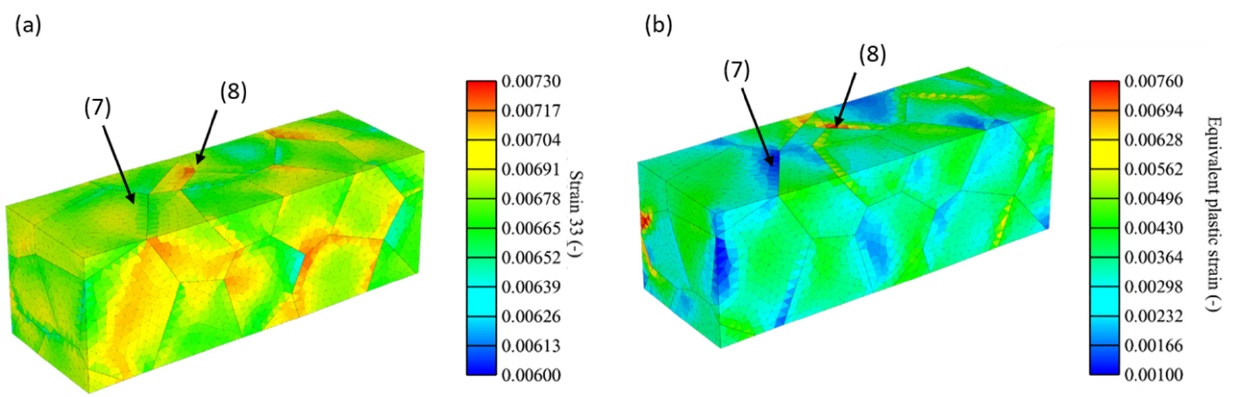
Figure 7. ( a ) Elastic strain S33 in loading direction and ( b ) equivalent plastic strain, for the soft ori- entated specimen.